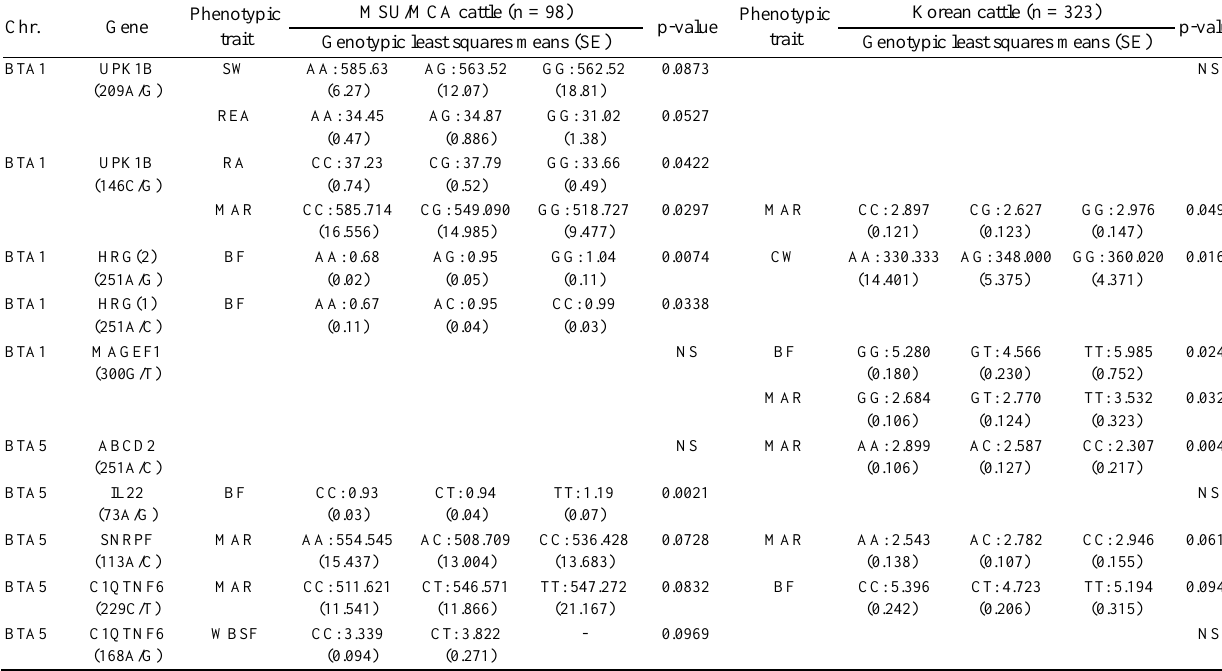
Table 5. Association of SNPs on BTA1 and BTA5 with growth and carcass traits for MCA/MSU and Koran cattle